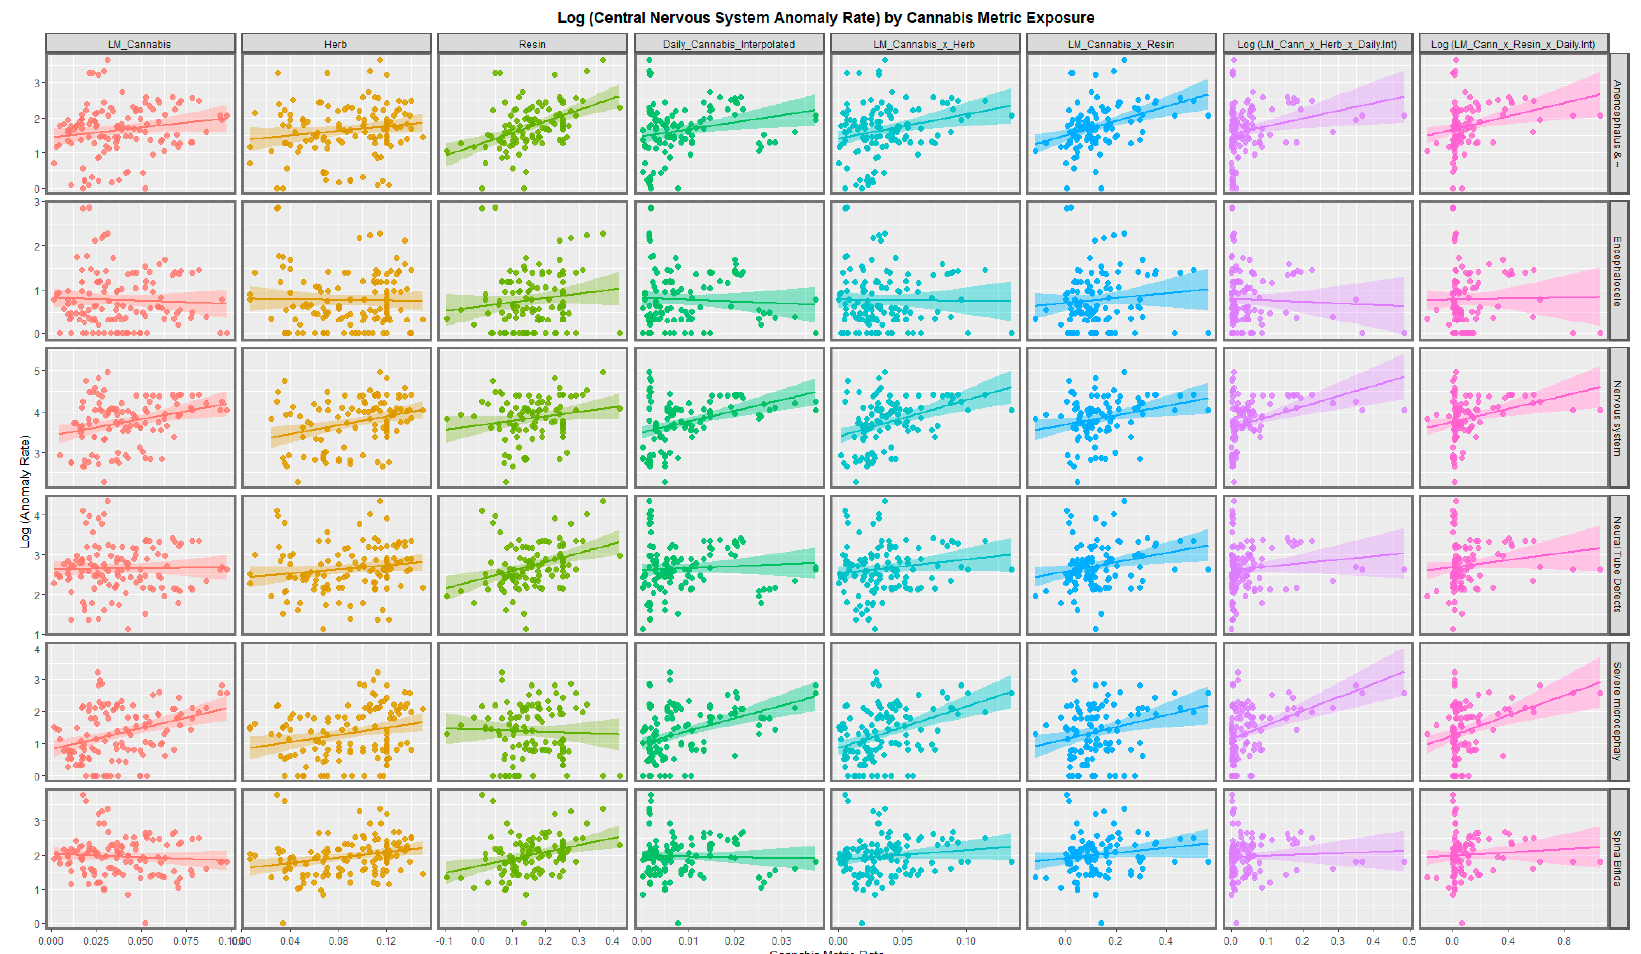
Figure 2. Paneled scatterplots for log (central nervous system congenital anomaly rates) by exposure to various metrics of cannabis for selected anomalies-1.